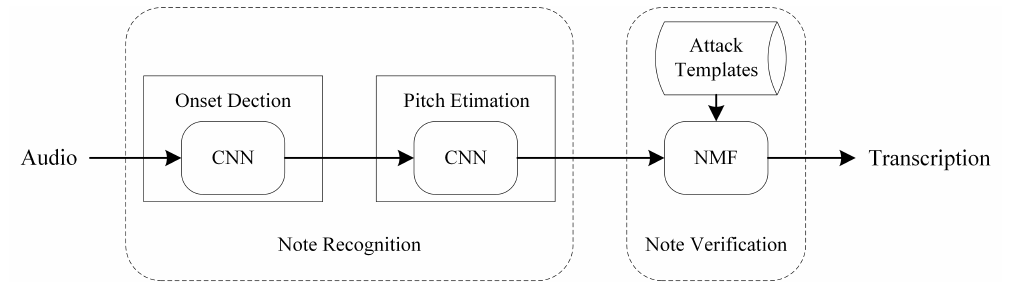
Figure 2. Diagram for the proposed framework. CNN: convolutional neural network; NMF: non-negative matrix